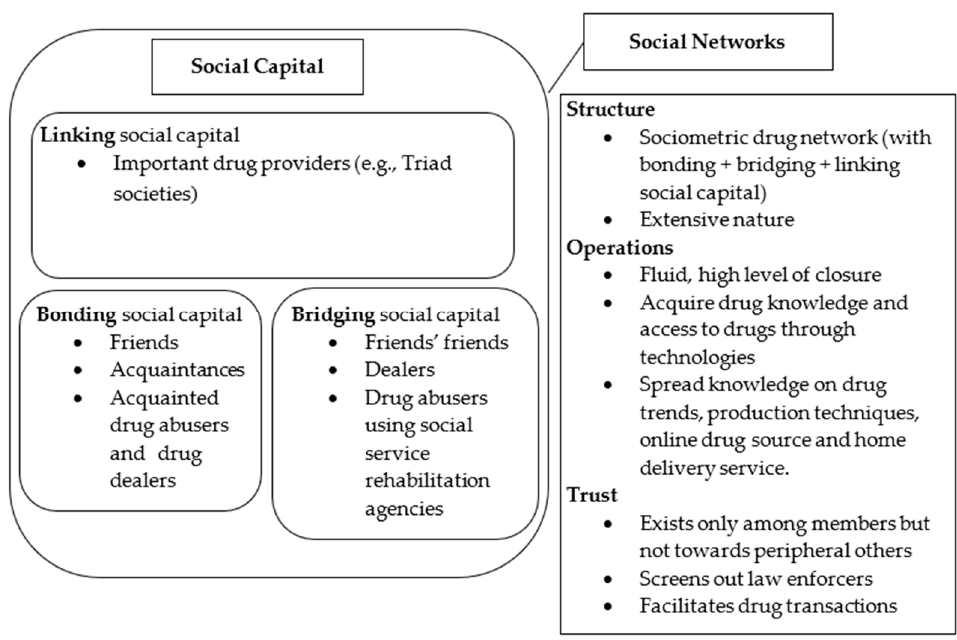
Figure 1. Social capital and social networks of drug abuse.